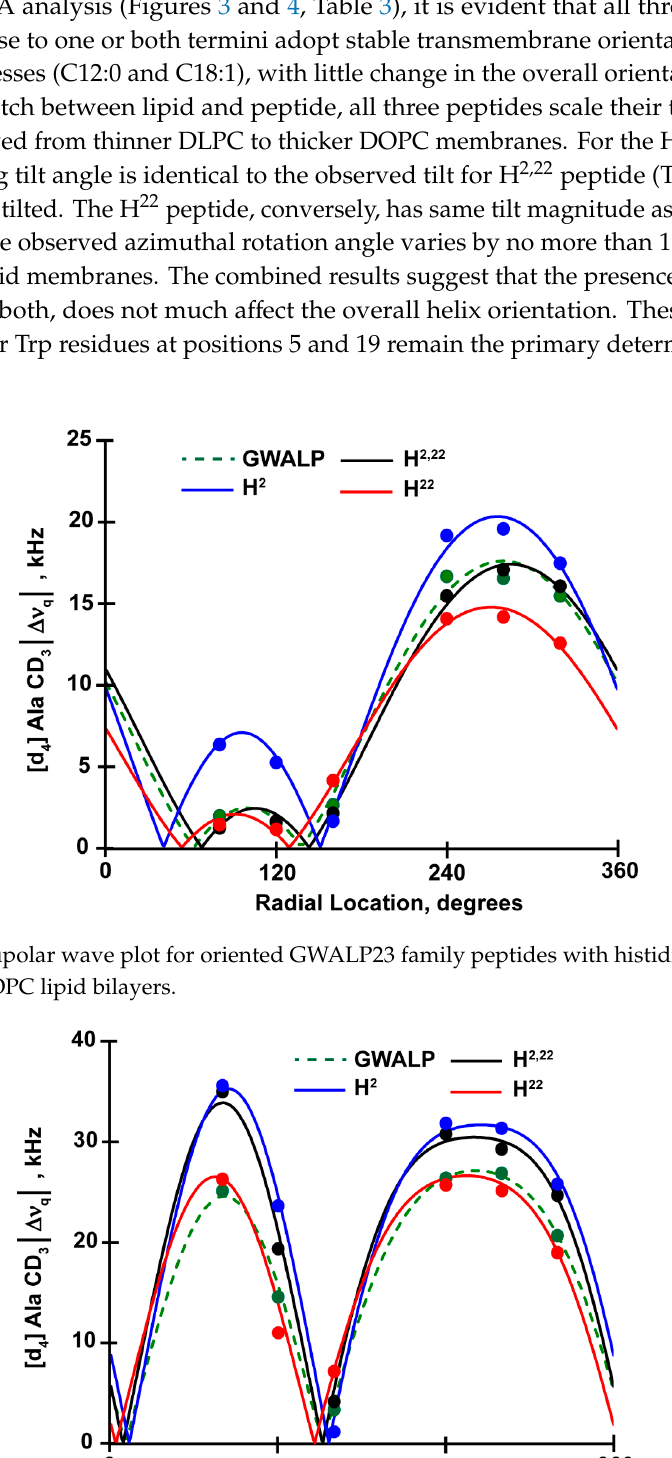
Figure 2. 2 H NMR spectra of H 2,22 WALP23, H 2 GWALP23 and H 22 GWALP23in DOPC lipid bilayers. The samples were hydrated with acetate buffers of pH 4. Temperature 50 °C; β =90° sample orientation.